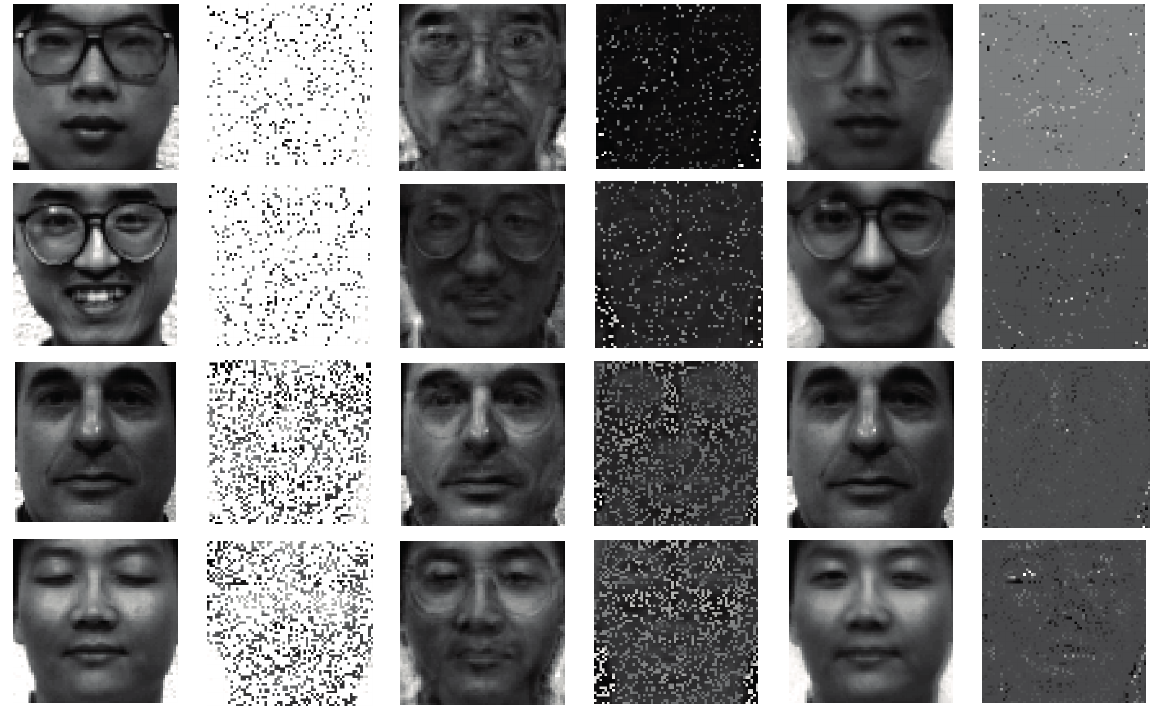
Figure 4. Completion and recovery performance comparisons on